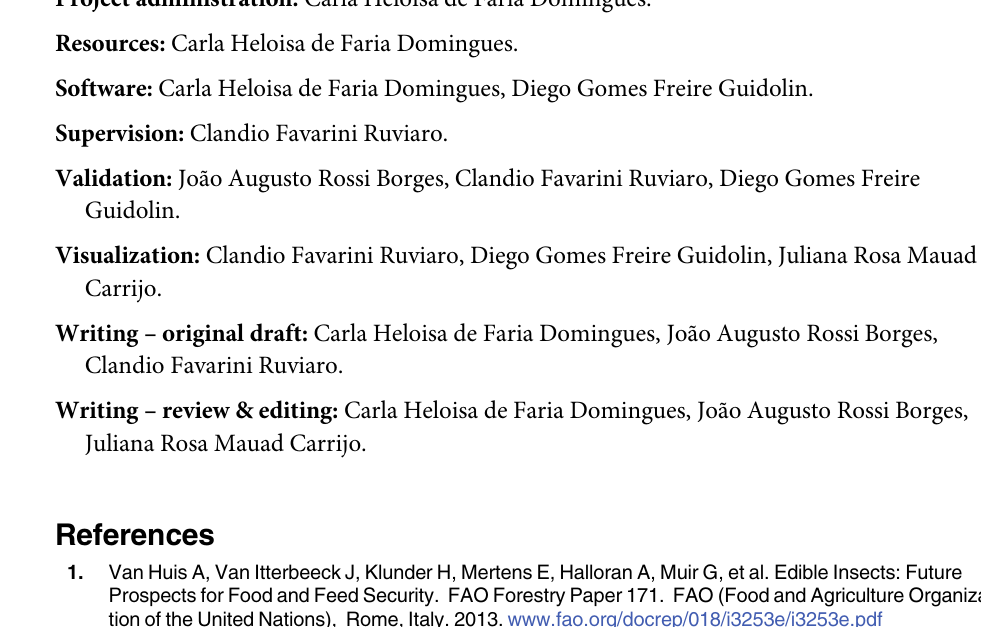
S5 Table. Descriptive statistics of attitude items used in the poultry, cattle, pig and fish questionnaires. S6 Table. Descriptive statistics of perception items used in the poultry, cattle, pig and fish questionnaires. S7 Table. Descriptive statistics of challenges items used in the poultry, cattle, pig and fish